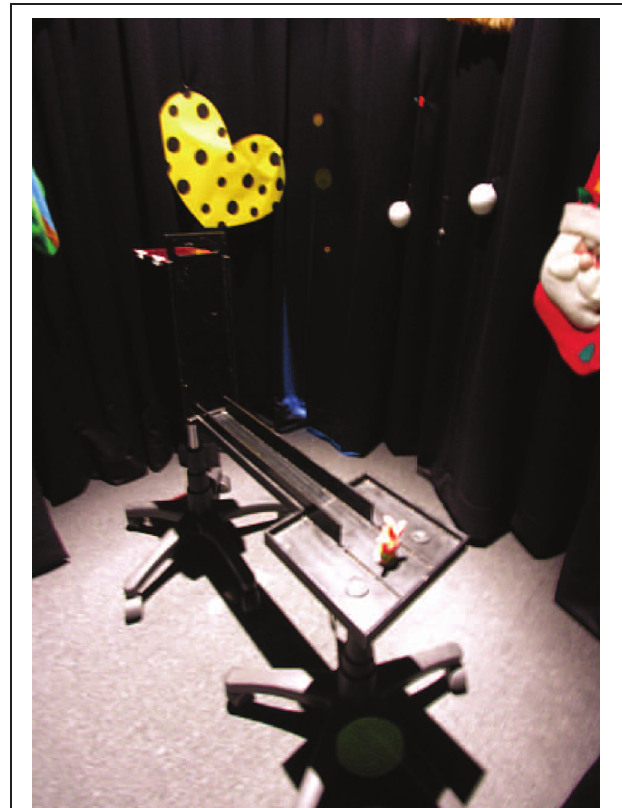
FIGURE 8 | An object-cued response selection task. The rat exits the start box and runs along the linear track and encounters an object cue (orange toy figure in this example). The object signals which disc on its left or right side should be displaced for successful retrieval of food. Rats are impaired in this task when the distal visual cues in the background are removed (by darkening the